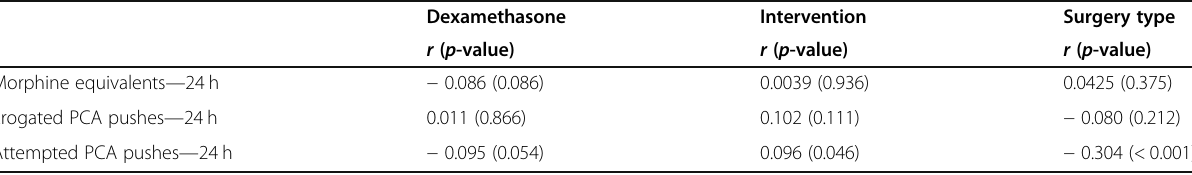
Table 4 Multivariate analysis on morphine consumption and PCA pushes Dexamethasone Intervention Surgery type